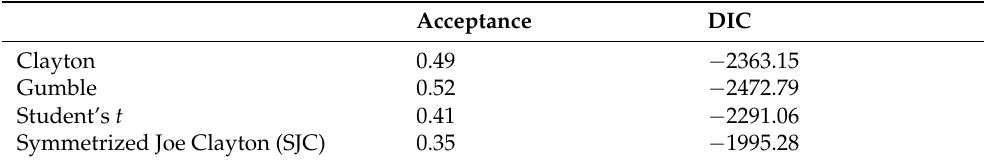
Table 5. Copula Selection